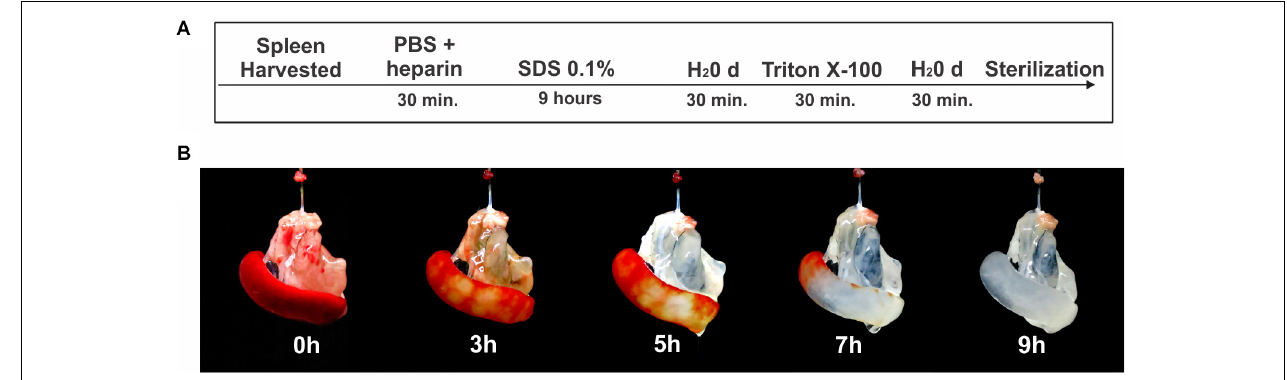
FIGURE 1 | Process of decellularization of the spleen. (A) Schematic representation of the protocol used for splenic decellularization. (B) Representative images of the splenic decellularization process over time.